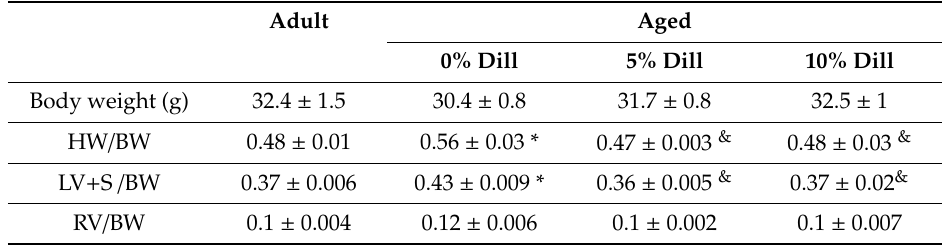
Table 1. Body weight (BW) and ratios of total heart weight (HW / BW), left ventricle plus septum weight (LV + S / BW), and right ventricle (RV / BW) to BW in untreated adult mice as well as untreated and DE-treated (5% or 10% v / v ) aged male mice.